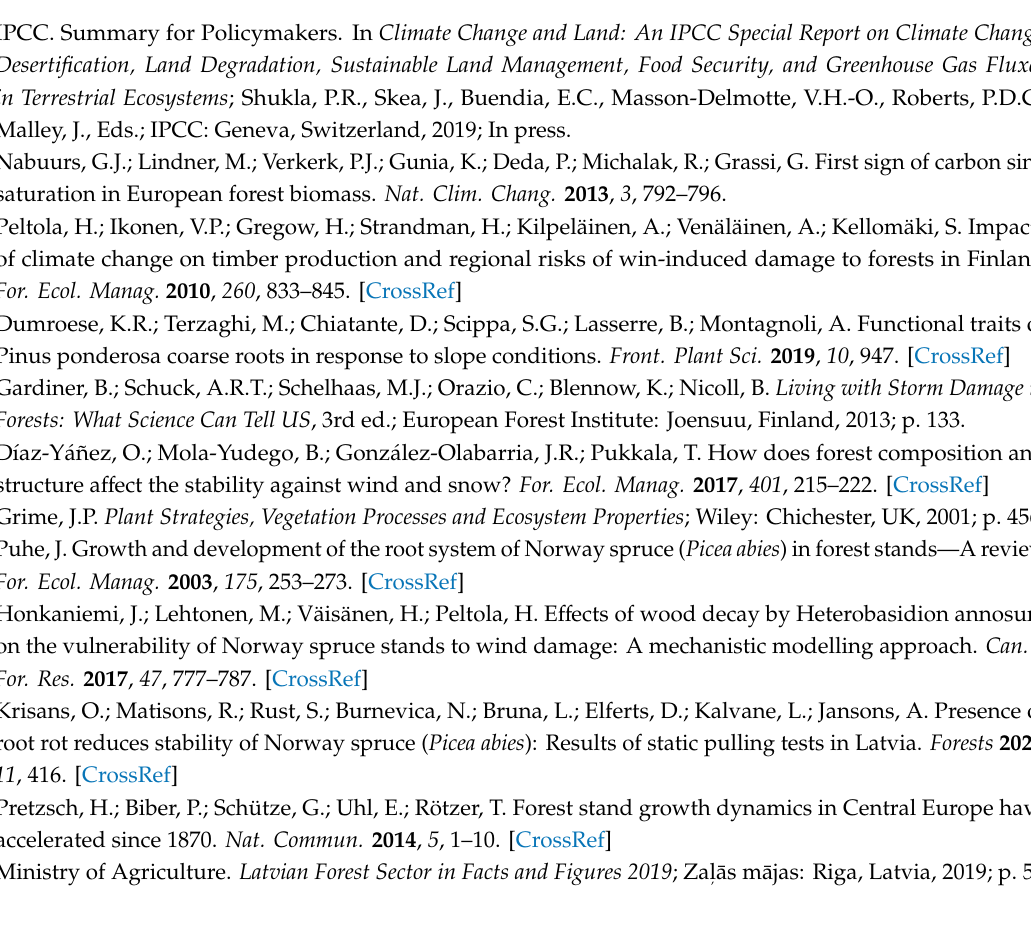
Figure S1: Schematic image of root-plate measurement